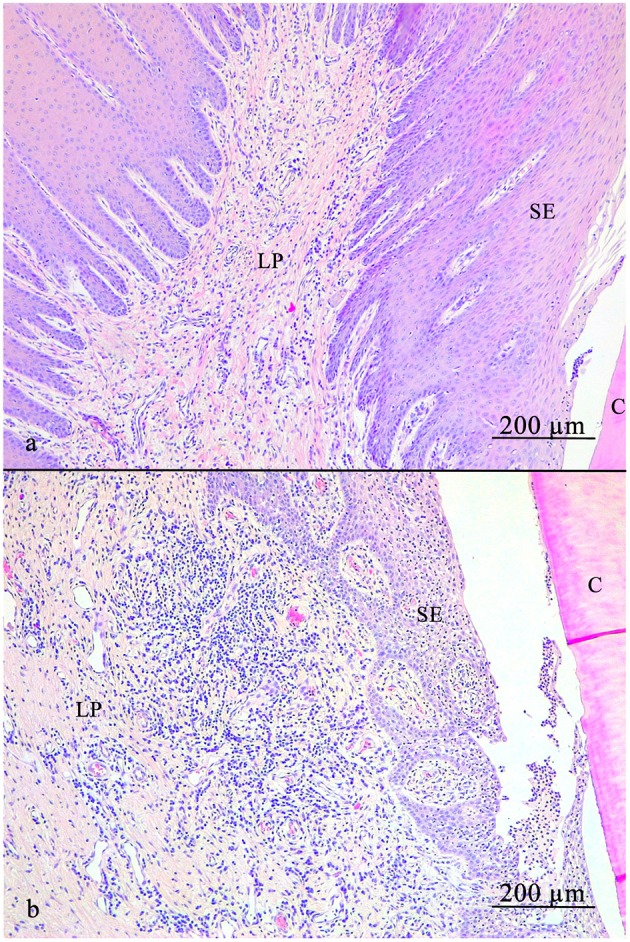
Lamina propria of the gingiva. (a) Note the diffusely spread blood vessels. (b) Local accumulation of leucocytic infiltrates near the sulcular epithelium (SE). C, cementum; SE, sulcular epithelium; LP, lamina propria.